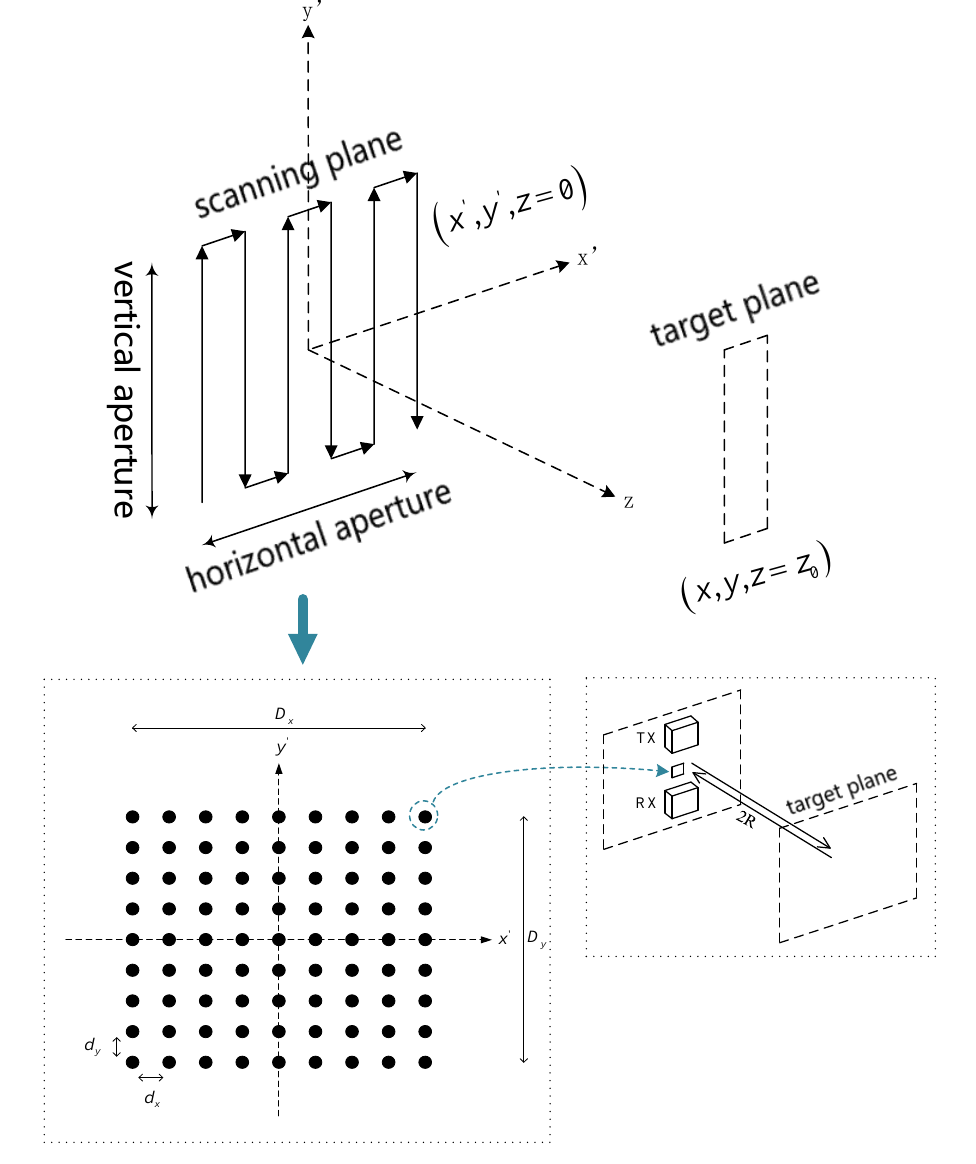
Figure 2. System Model (The motion trajectory of SAR in this paper is shown on the top; the synthesized virtual array is shown on the left below, and the monostatic is shown on the right. The interconnection between them is indicated by arrows).